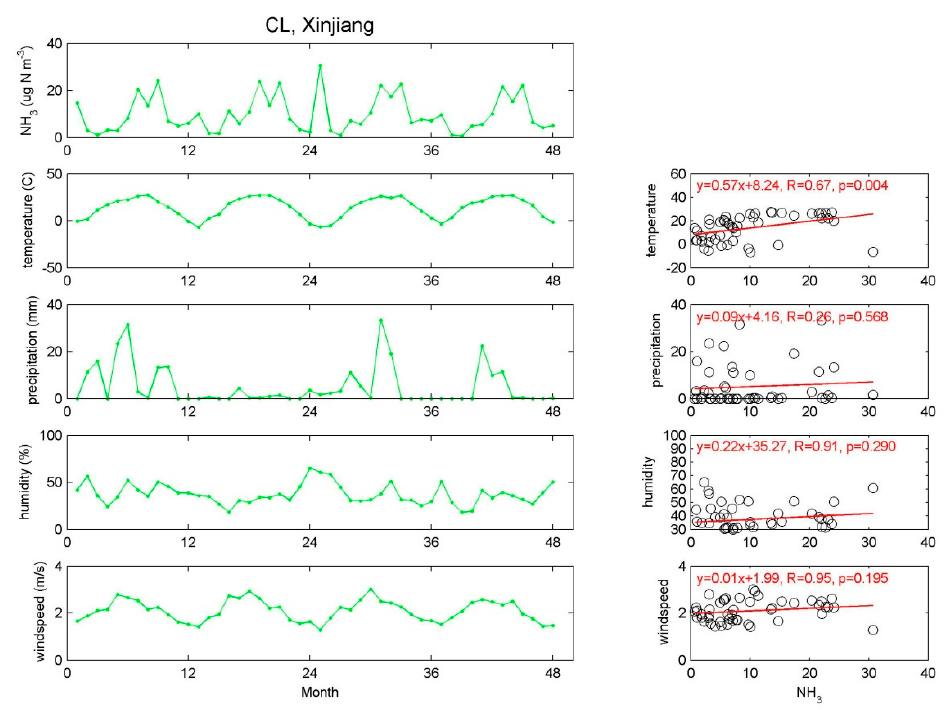
Figure A6. The seasonal variations of ground NH 3 concentrations (µg N m − 3 ), temperature (°C), precipitation (mm), humidity (%), and wind speed (m/s) at CL from January 2010 to December 2013 (0–12, 2010; 13–24, 2011; 25–36, 2012; 37–48, 2013).